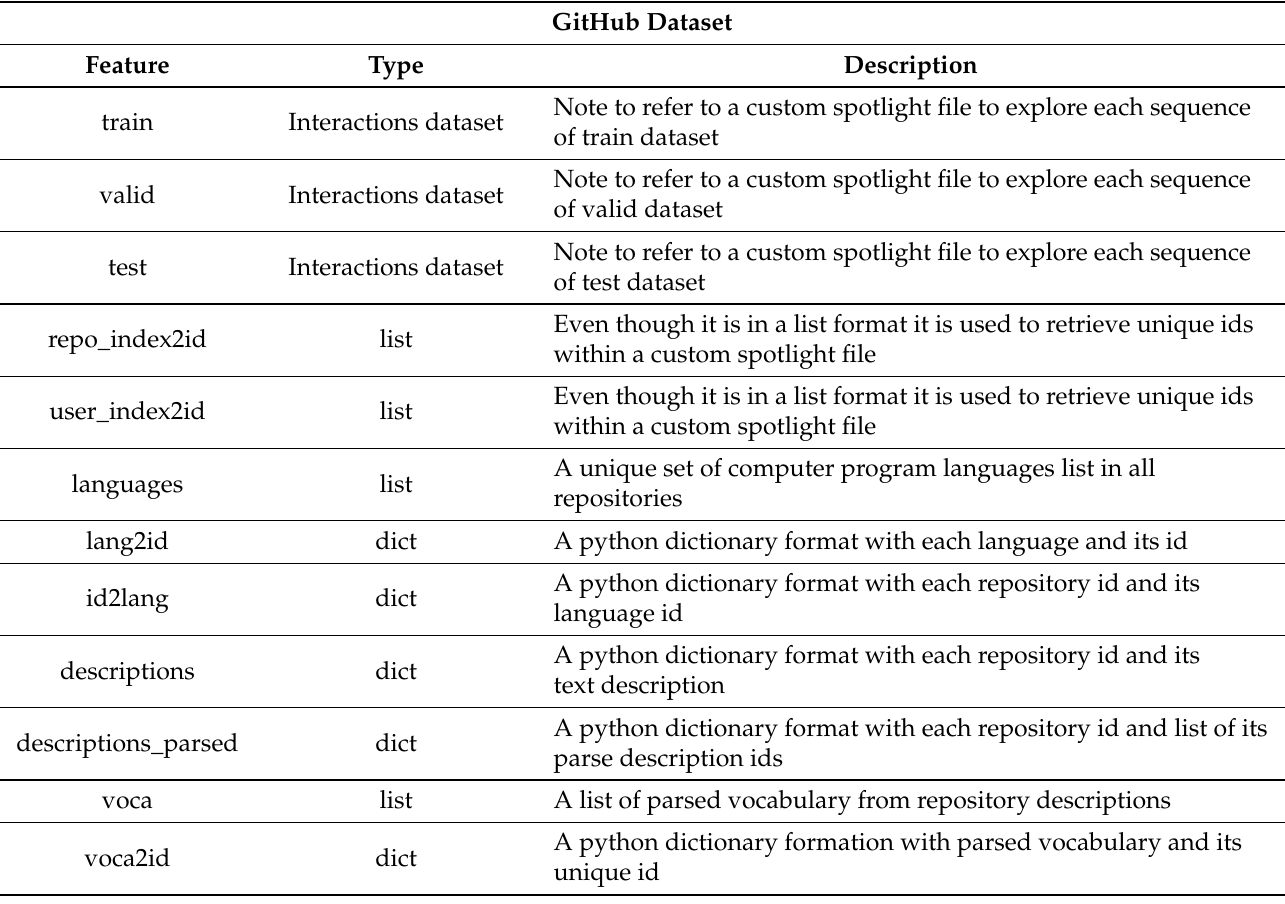
Table 1. Summary of GitHub dataset features.